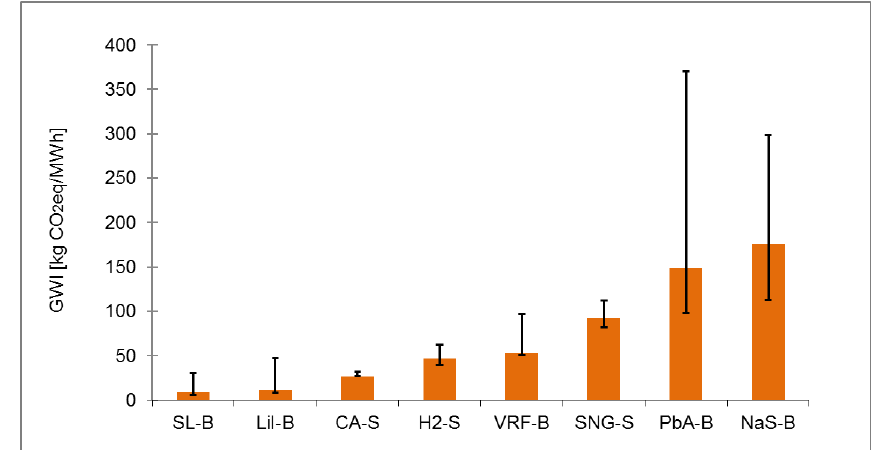
Figure 5. Change in global warming impact GWI per fed-out electricity for shorter and longer lifetime of electrical energy storage technologies.